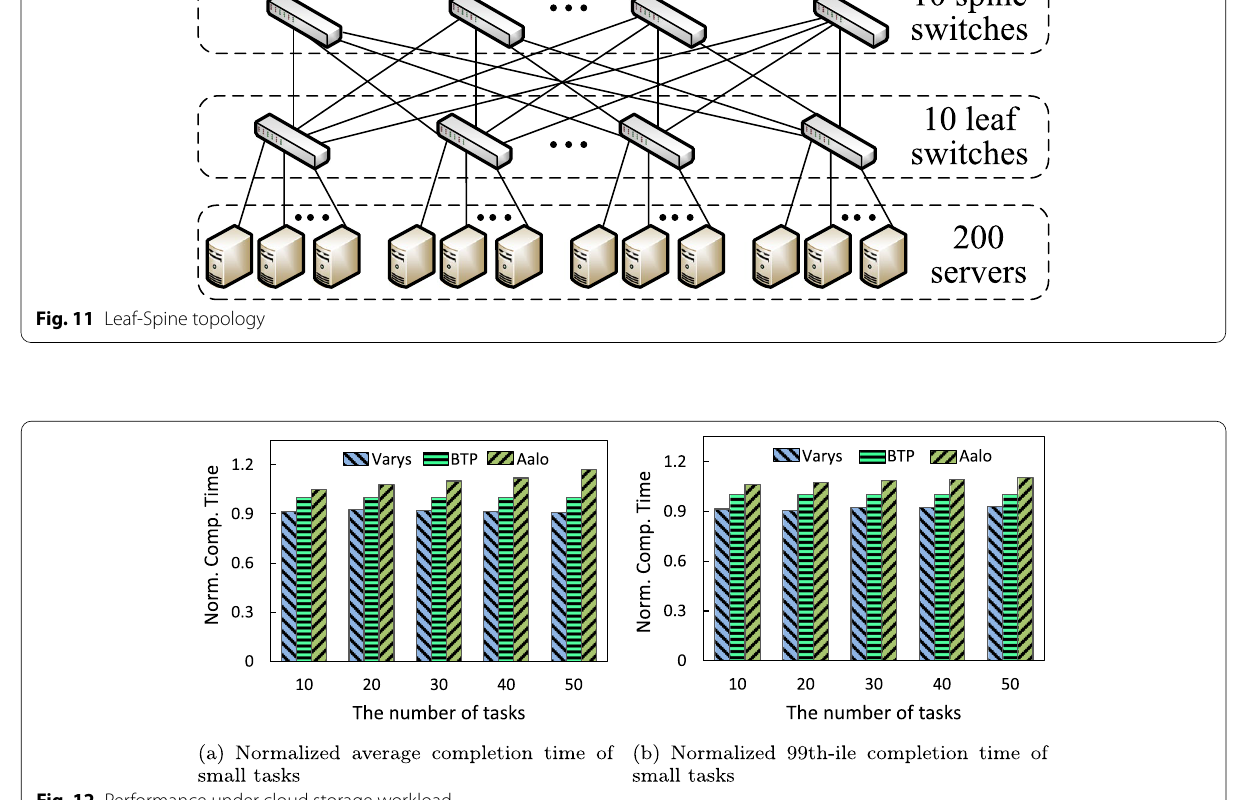
Fig. 12 Performance under cloud storage